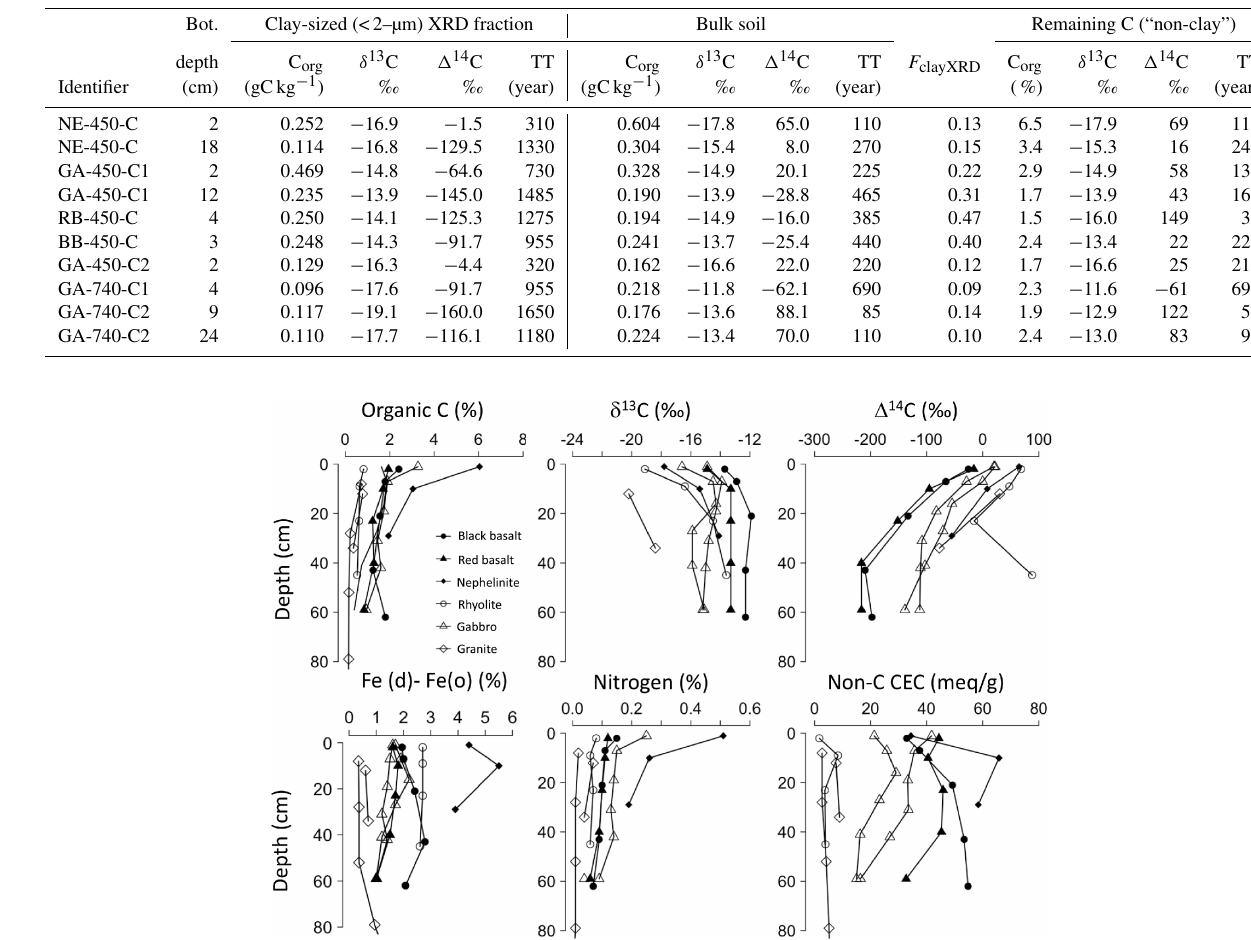
Table 4. Measurements of C and isotopes in the bulk soil and clay-sized XRD fraction, the same fraction analyzed for quantitative mineralogy (Table 2). The fraction of bulk C in the clay-sized XRD fraction ( F clayXRD ) and the characteristics of the C making up the rest of the bulk C are calculated using Eqs. (1)–(3) given in the text. Horizon bottom depths (Bot. depth) >10cm indicate B1 horizons; we excluded data from sampled depths>20cm. We cannot rule out the potential for carbonates making up a small fraction of the Clay XRD fraction for the dry gabbro (GA-450-C1) Bw horizon sample as these were not acidified prior to combustion and carbonates were found using XRD in this soil. All other Clay XRD samples did not contain measurable carbonates (Table 2).